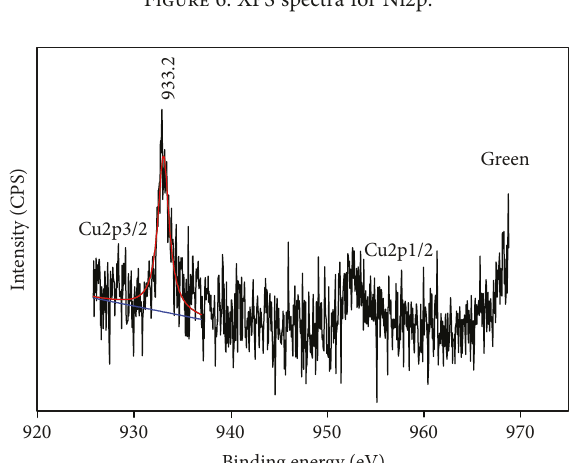
Figure 6: XPS spectra for Ni2p.